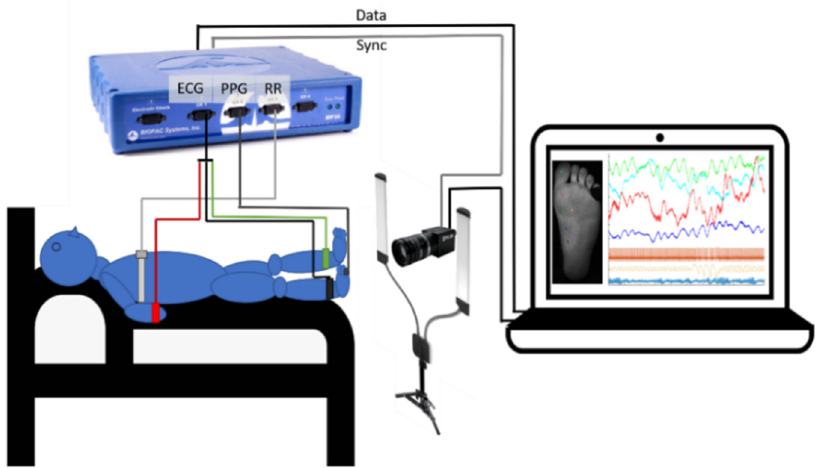
Figure 1. Measurement Setup—BIOPAC (ECG, PPG, RR), FLIR machine vision camera (BFS-U3- 28S5M), LED illumination source and registration unit (laptop).